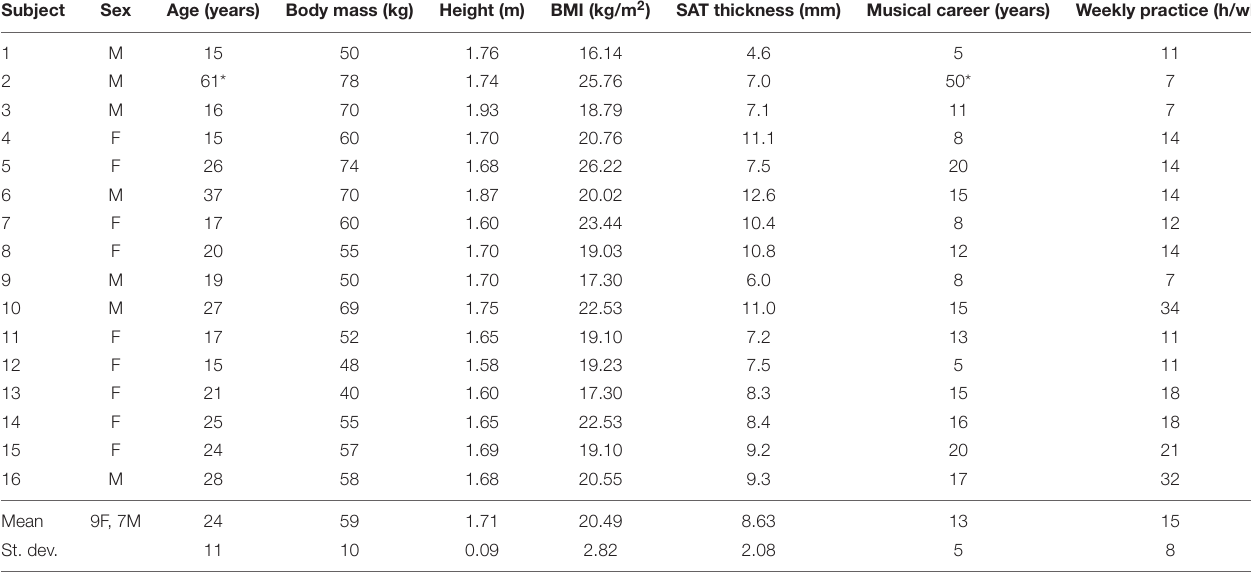
TABLE 1 | Demographic and anthropometric data of the 16 pianists and their musical